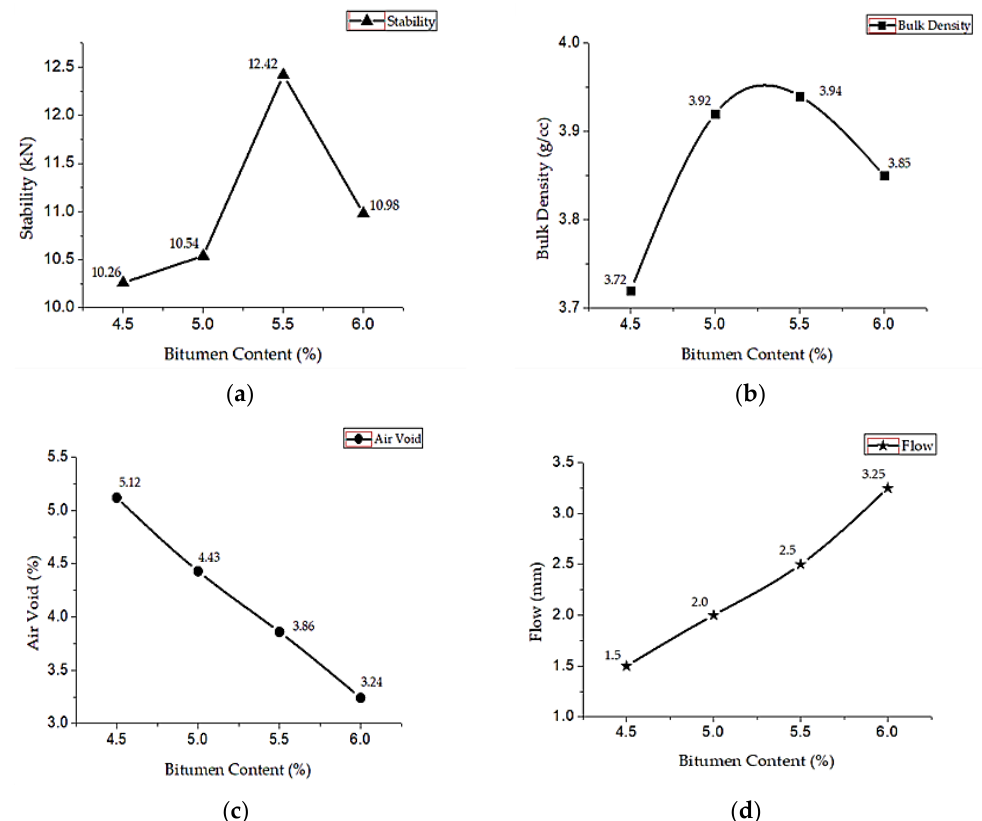
Table 6. Marshall Test Results for Sustainable Mixes.